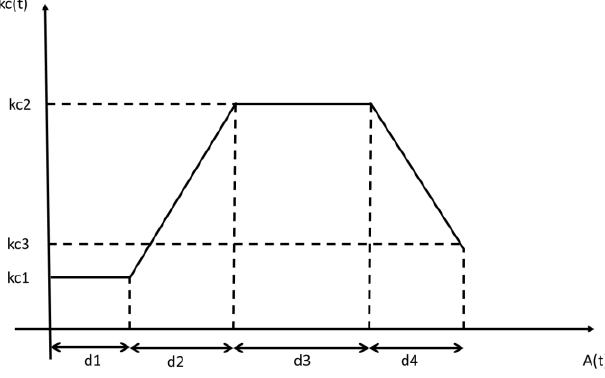
Figure A1. the multistage crop coefficient. From FAO56 [33]. Figure A1. The multistage crop coefficient. From FAO56